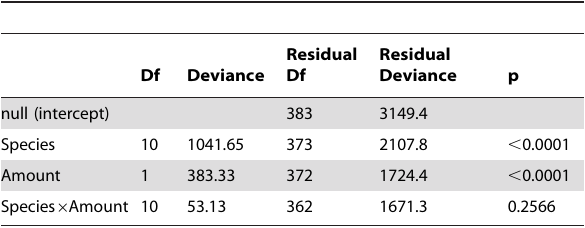
Table 2. ANOVA result of the effect of species and amount of SC on C. gigas larval settlement.